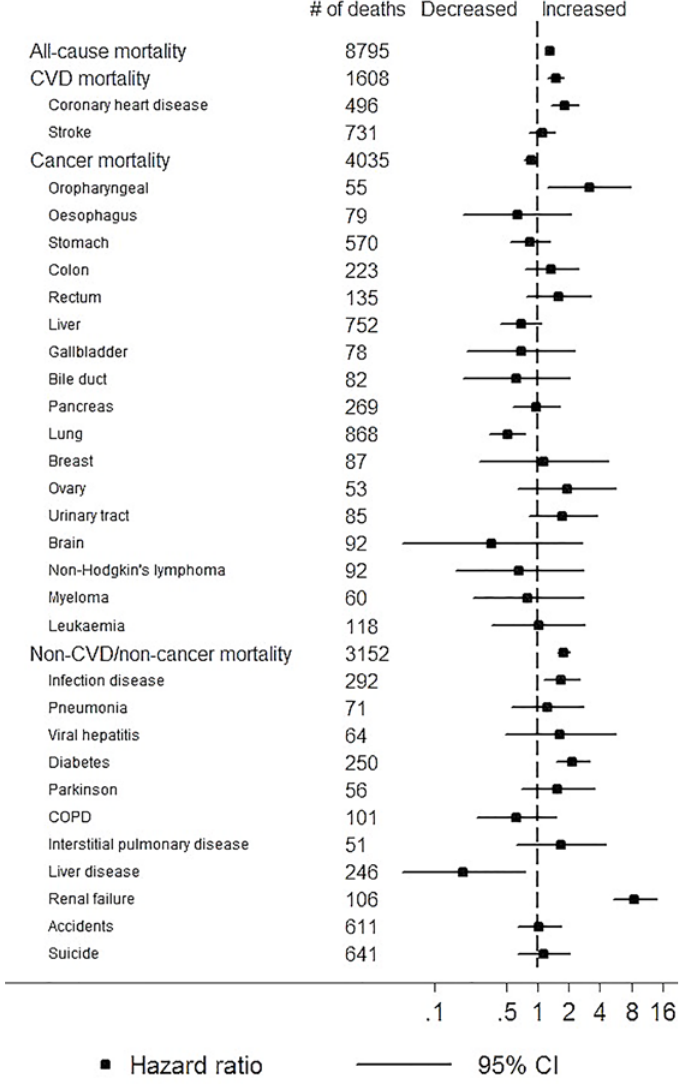
Fig 3. Adjusted hazard ratios of cause-specific mortality for eGFR < 60 ml/min/1.73m 2 (vs. ≥